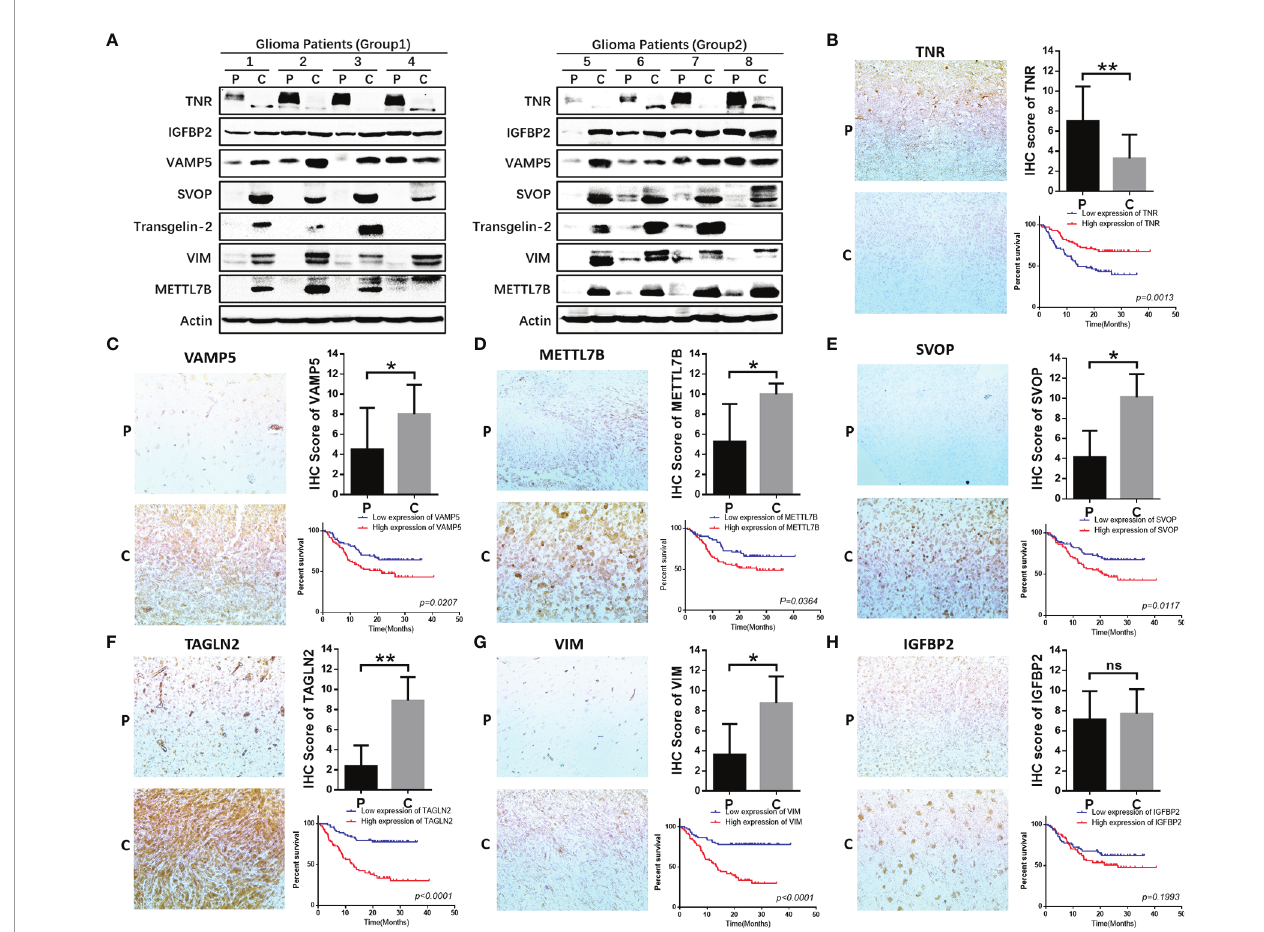
FIGURE 9 | Functional validation of 7 hub genes in clinical specimens. (A) WB assay was used to detect the expression differences of 7 core genes in glioma tissues and adjacent tissues. (B – H) Immunohistochemical staining and statistical analysis of tumor and adjacent tissues in patients with glioma, and Kaplan-Meier curve analysis of overall survival in glioma patients by the expression of 7 core genes. Death/total number of patients in each subgroup were presented. (P, paracancerous; C, cancer). *P ≤ 0.05, **P ≤ 0.01, ***P ≤ 0.001. ns, no signi fi